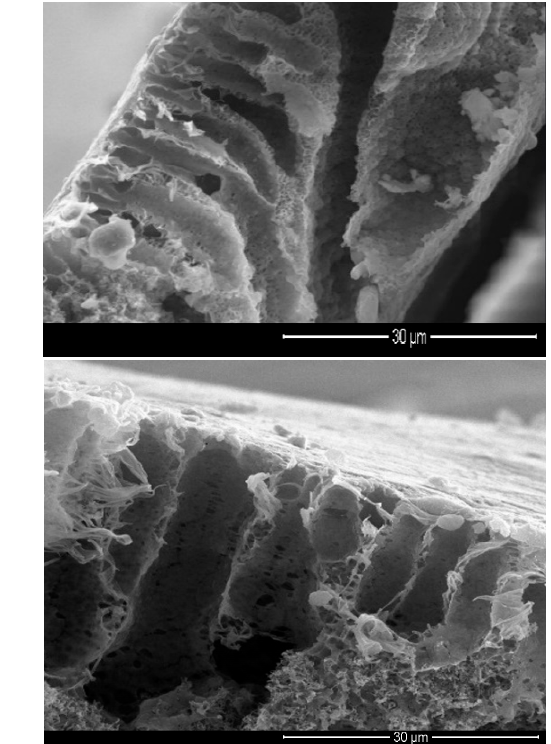
Figure 7. ( A – D ) Different modified Membrane’s top surface and cross-sectional SEM images at 10 µm and 30 µm magnifications respectively; ( A ) pristine, ( B ) PP, ( C ) PPC-0.05, ( D ) PPC-0.3.